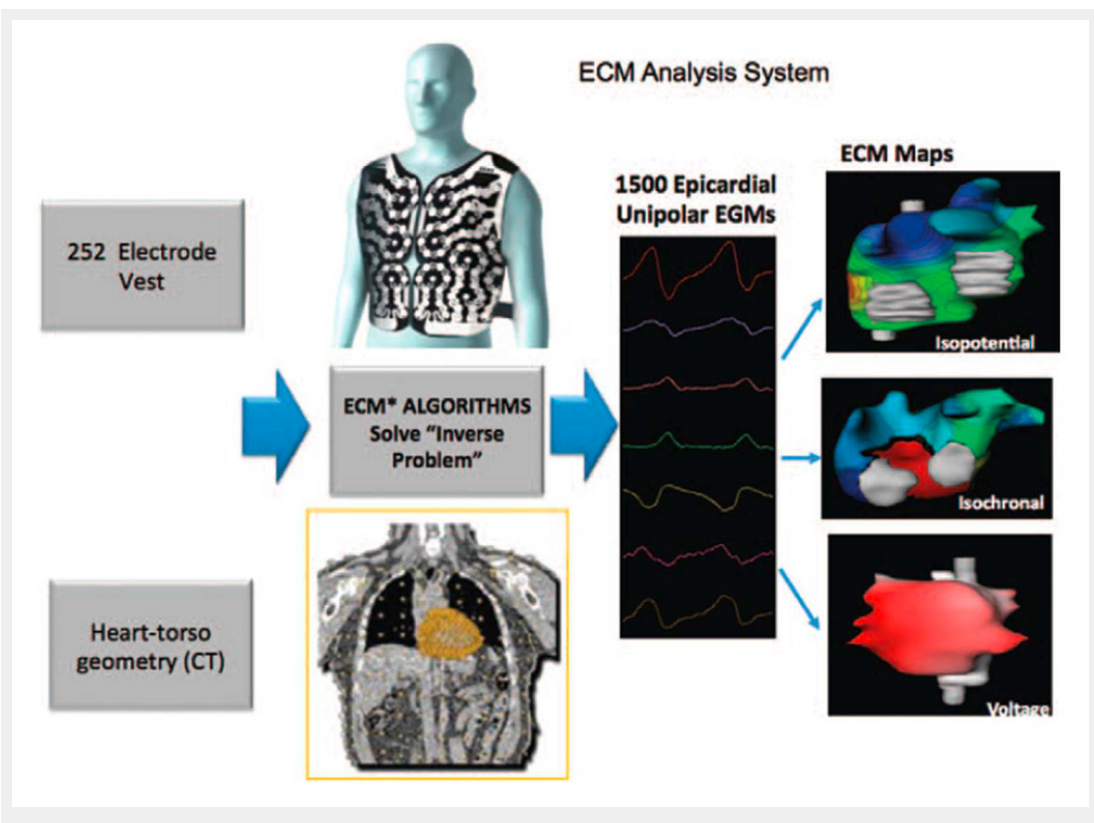
Figure 3 Overview of the components of the ECG mapping system. The key component of the mapping system is the 252 electrodes that are embedded in a vest that can easily be placed on a patient torso. With the vest on, a computed tomographic (CT) scan of the chest obtains the precise anatomical relation between the 252 electrodes on the vest and the epicardial surface of the heart. Once this anatomic relation is defined, 1500 unipolar electrograms can be calculated from the 252 electrodes using the inverse solution method. Next, isopotential, isochronal, and voltage maps can be reconstructed out of the 1500 unipolar electrograms (reproduced from Cakulev et al. [66] with